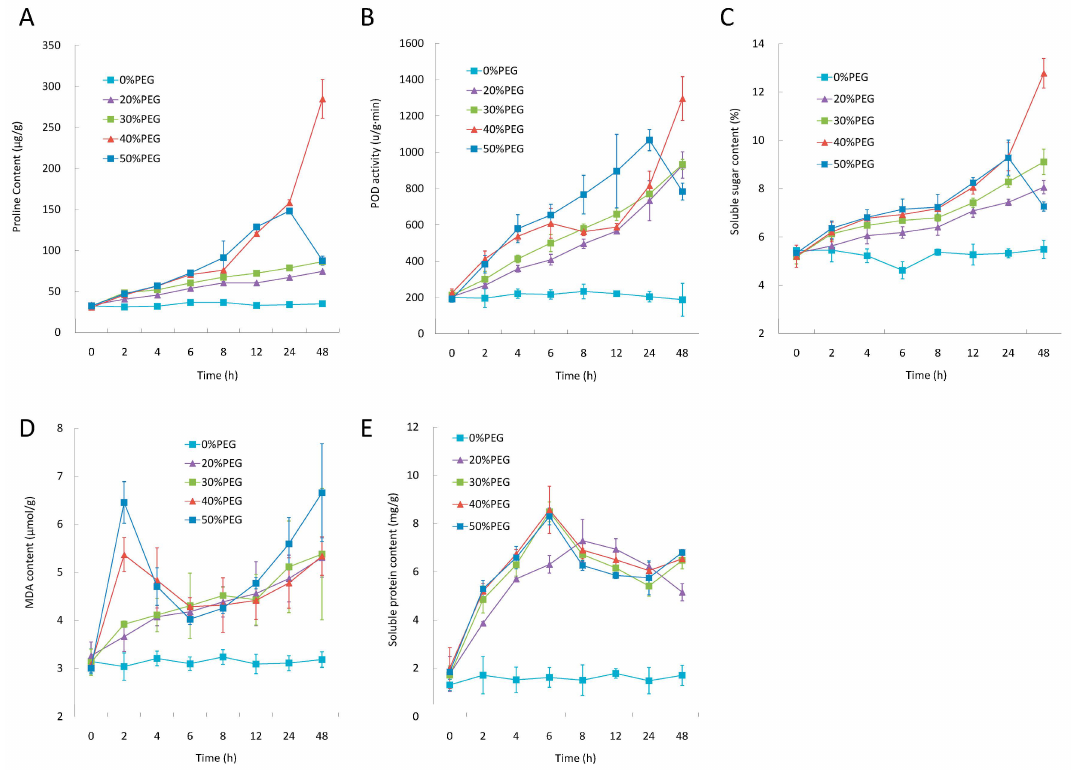
Figure 1. Physiological changes of cassava leaves in response to PEG treatments. Proline content ( A ); POD activity ( B ); soluble sugar content ( C ); MDA content ( D ); and soluble protein content ( E ) were investigated under different PEG concentrations (0%, 20%, 30%, 40% and 50%) across eight time points (0, 2, 4, 6, 8, 12, 24 and 48 h) within 48